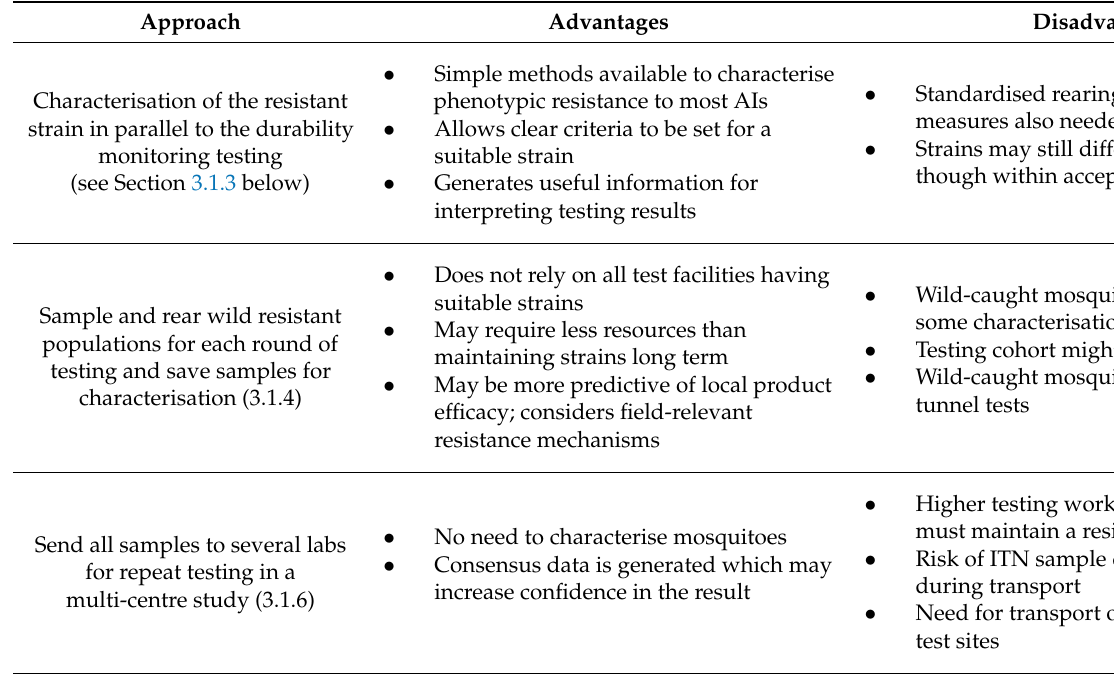
Table 1. Possible approaches to achieve sufficient standardisation or characterisation of pyrethroid-resistant mosquitoes used for bioefficacy bioassays of dual-AI ITNs to compile, compare, and interpret results across studies. All approaches were proposed and considered by members of the stakeholder group and a consensus opinion reached as to their suitability and practicability; these are listed from most to least preferred or feasible